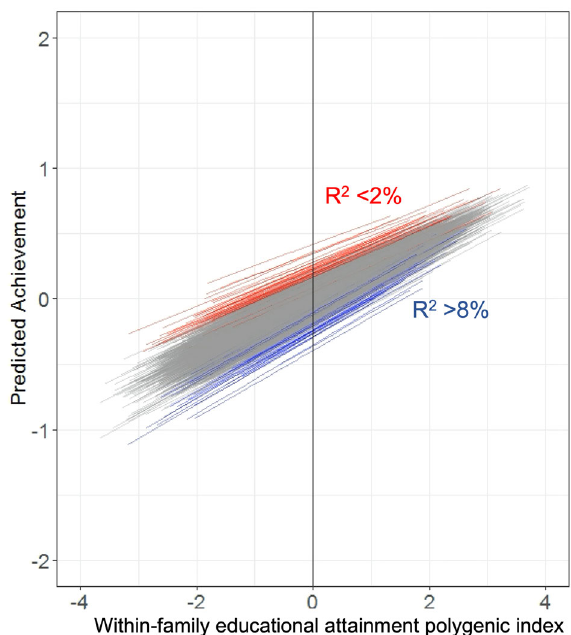
Fig. 2 School-speci fi c associations between the within-family EA- PGI and achievement. In red are regression lines for the 2.5% schools in which within-family EA-PGI effects are weakest; in blue are the 2.5% of schools where PGI effects are strongest; R 2 = variance explained in achievement. The within-family EA-PGI has a weaker effect in schools where average student achievement is higher. School differences in achievement are wider among students with lower EA-PGI. Note that the sample size was 23471 children attending 2578